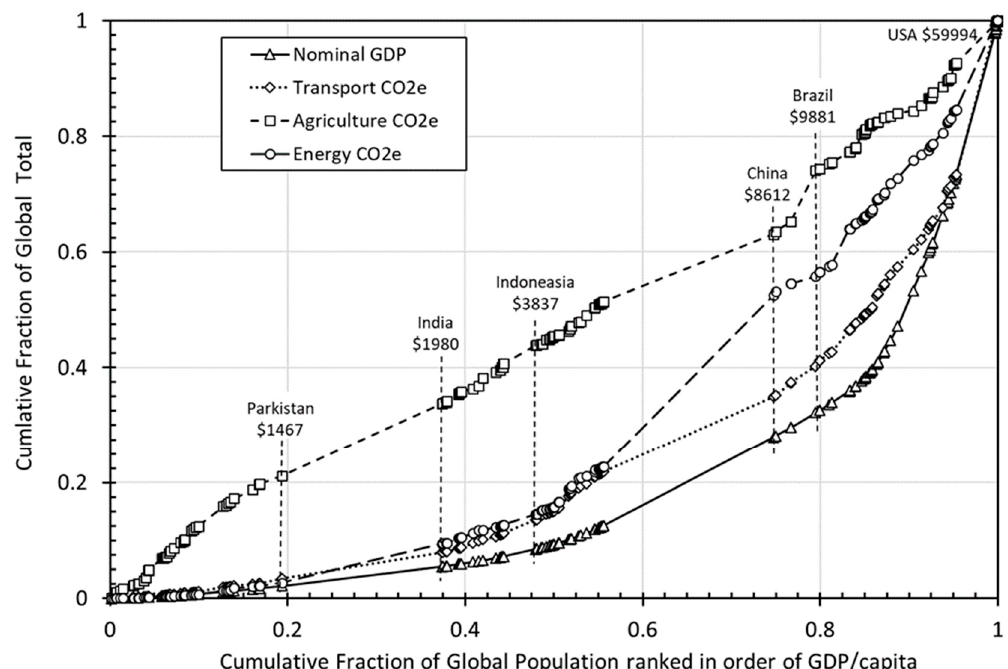
Figure 2. Distribution of nominal GDP (USD 2017), and 2019 CO 2 -eq emissions from transport, ag- riculture and energy. Note: Distribution presented as cumulative fractions of the global total (190 countries) for each sector, all ranked in order of increasing nominal GDP/capita. GDP/capita for the six most populated countries shown. The data are drawn from [82,92].